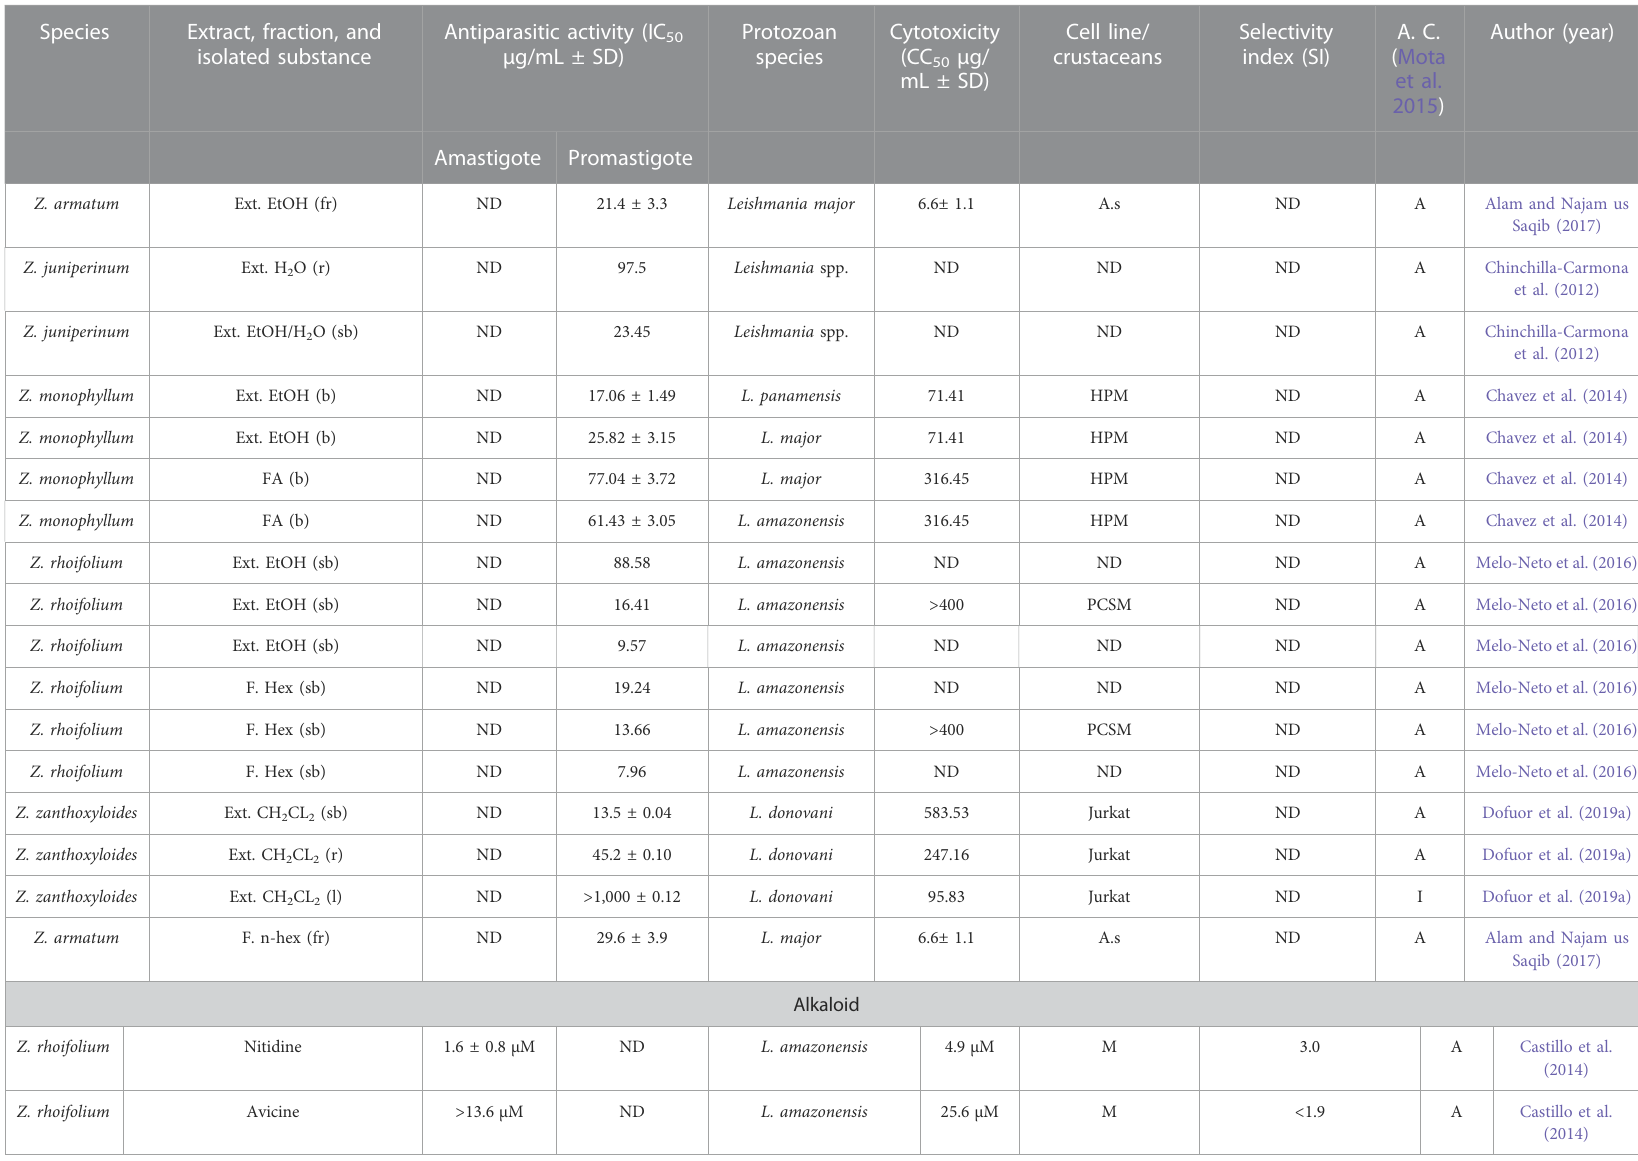
TABLE 5 In vitro antiparasitic activity against the genus Leishmania